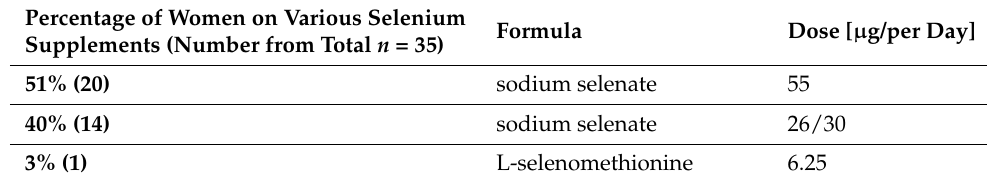
Table 3. Self-reported intake of Se-containing supplements during pregnancy.